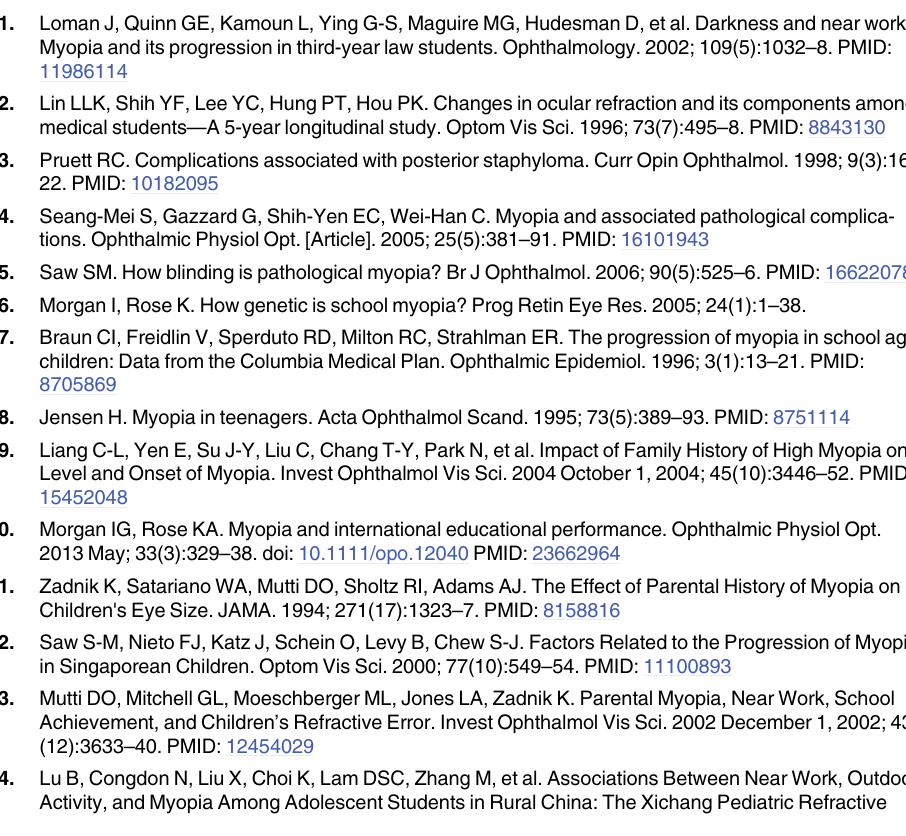
S1 Table. Patient and study characteristics of the total included studies. S2 Table. Cross sectional studies investigating the correlation between near work activities and myopia. S3 Table. Cohort studies investigating the relationship between near work activities and incidence of myopia. S4 Table. Studies investigating the correlation between near work activities and the pro- gression of